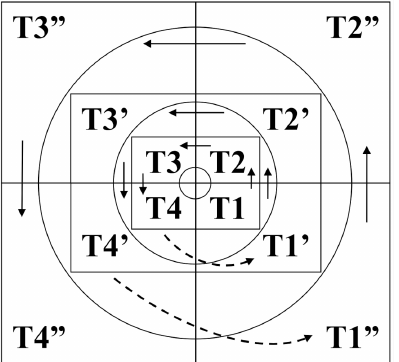
Figure 2. Extended situational teaching, after Tehrani (2011)